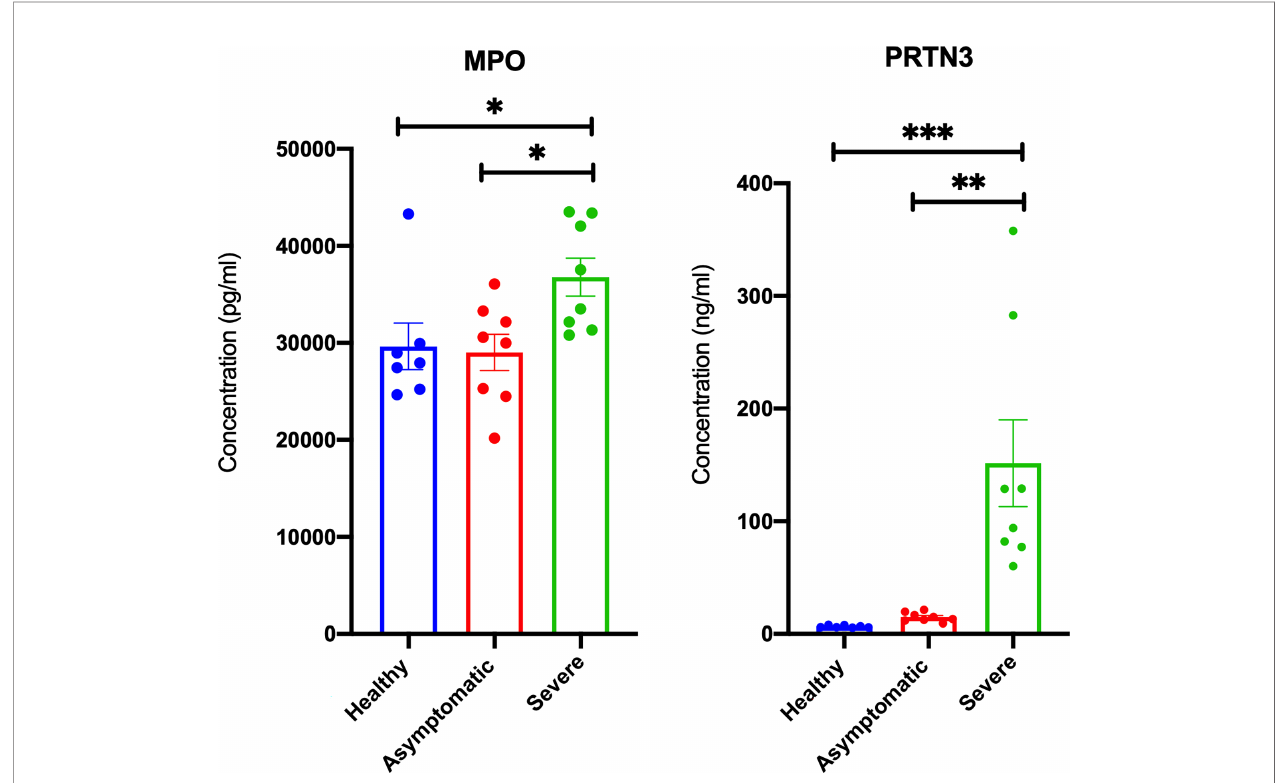
FIGURE 5 | Elevated plasma MPO and PRTN3 levels in severe COIVD-19 patients. An increase in the plasma levels of MPO and PRTN3 in severe compared to asymptomatic COVID-19 patients. The protein levels were estimated using human ELISA assays (n = non-infected controls, n = 8 asymptomatic COVID-19, and severe n = 8 COVID-19). ∗ p < 0.05, ∗∗ p < 0.01, ∗∗∗ p <